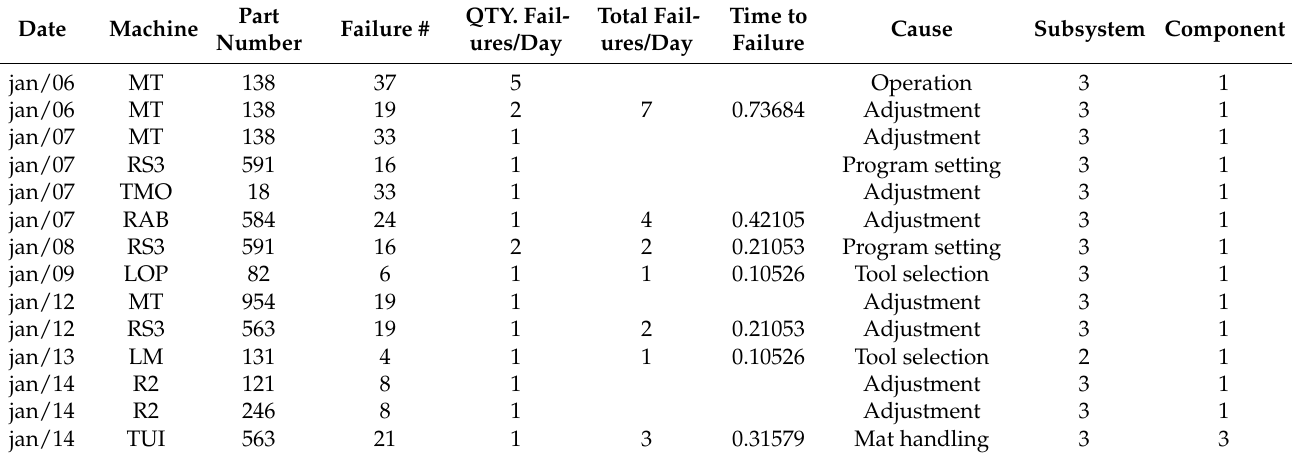
Table 4. Database used to collect and analyze failures that occurred in machine